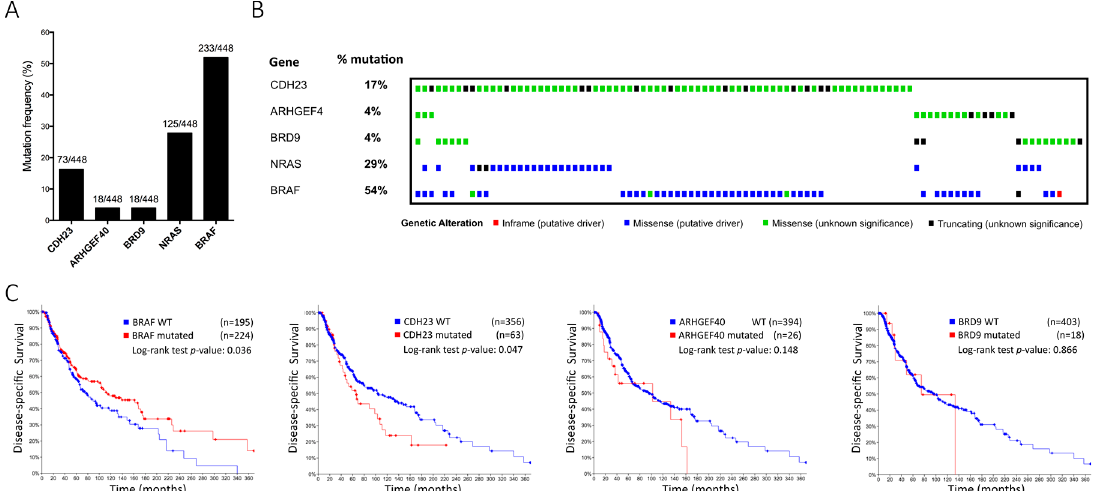
Figure 2 . ( A , B ) Mutation frequency and heatmap from the TCGA dataset. Mutation significance is represented as follows: Inframe (putative driver)—red square; Missense (putative driver)—blue square; Missense (unknown significance)—green square; Truncating (unknown significance)—black square. ( C ) Disease-specific survival for BRAF , CDH23 , ARHGEF40, and BRD9 mutations in a combination of seven independent cohorts (TCGA, Snyder, Broad 2014, Broad 2012, Broad/DFCI, Van Allen and Yale). Total cases with survival data for each gene are BRAF = 419; CDH23 = 419; ARHGEF40 = 420; BRD9 = 421.